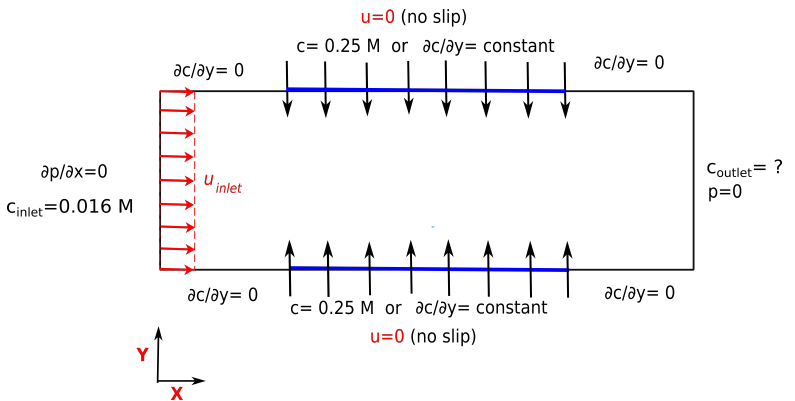
Figure 5. Illustration of boundary conditions in a flat channel. Zero flux conditions are applied for sections up- and downstream of the active membrane (blue horizontal line) to mitigate the influence of the in- and outlet. Active membrane regions have either a constant concentration equal to 250 mol/m 3 or an equivalent